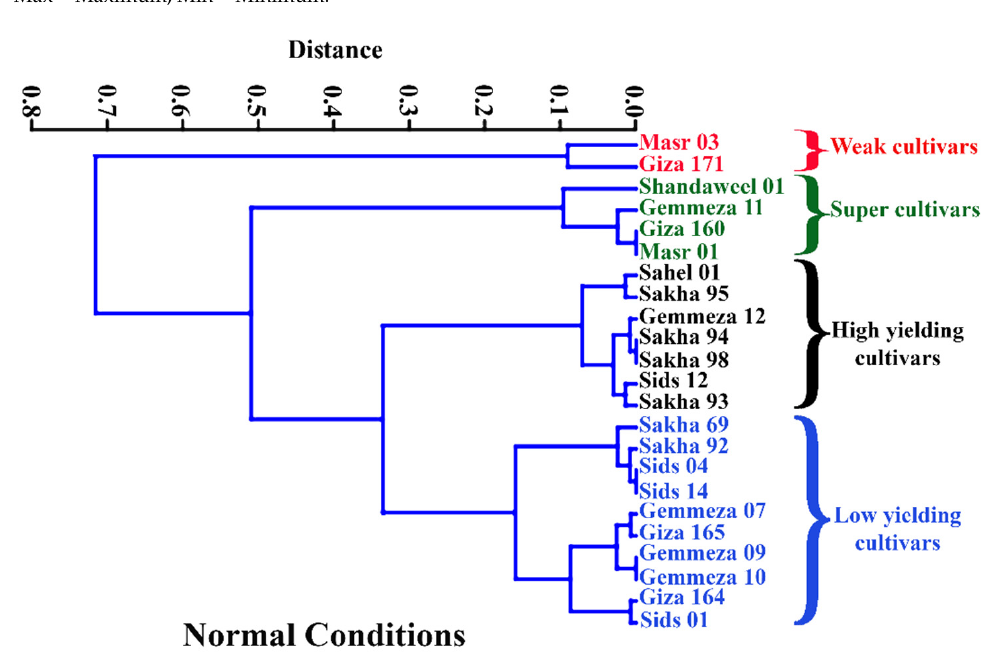
Figure 10. Dendrogram using Ward’s method among groups showing the classification of genotypes based on the combined grain yield per m 2 under normal conditions.